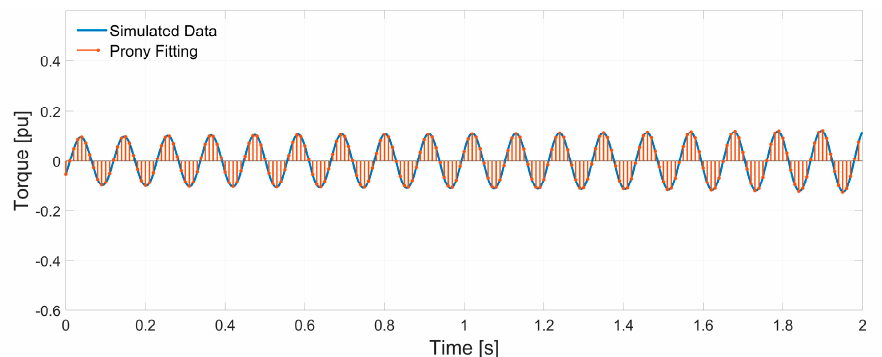
Figure 17. TG shaft-line torque in configuration CB (simulation results).